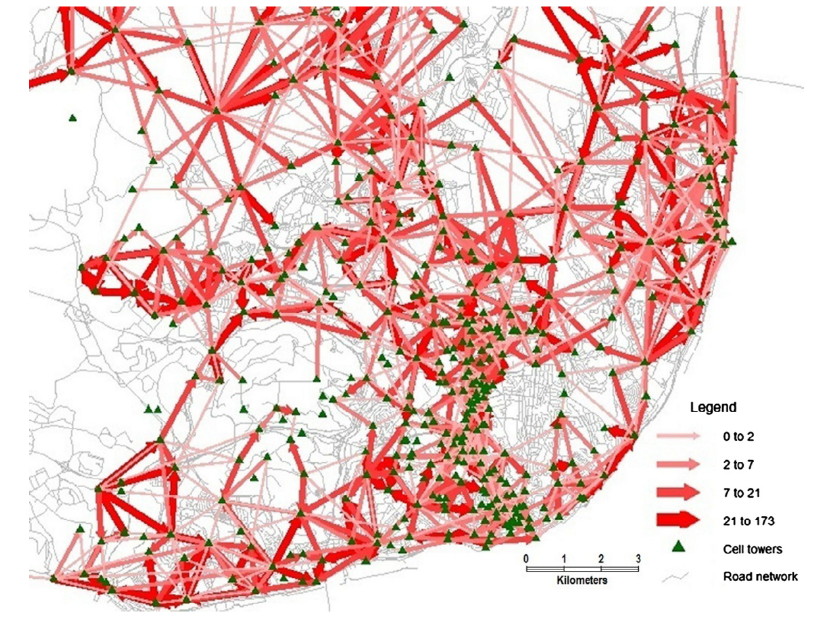
Figure 7. Map-based visualization of handover flows using flow maps [40].